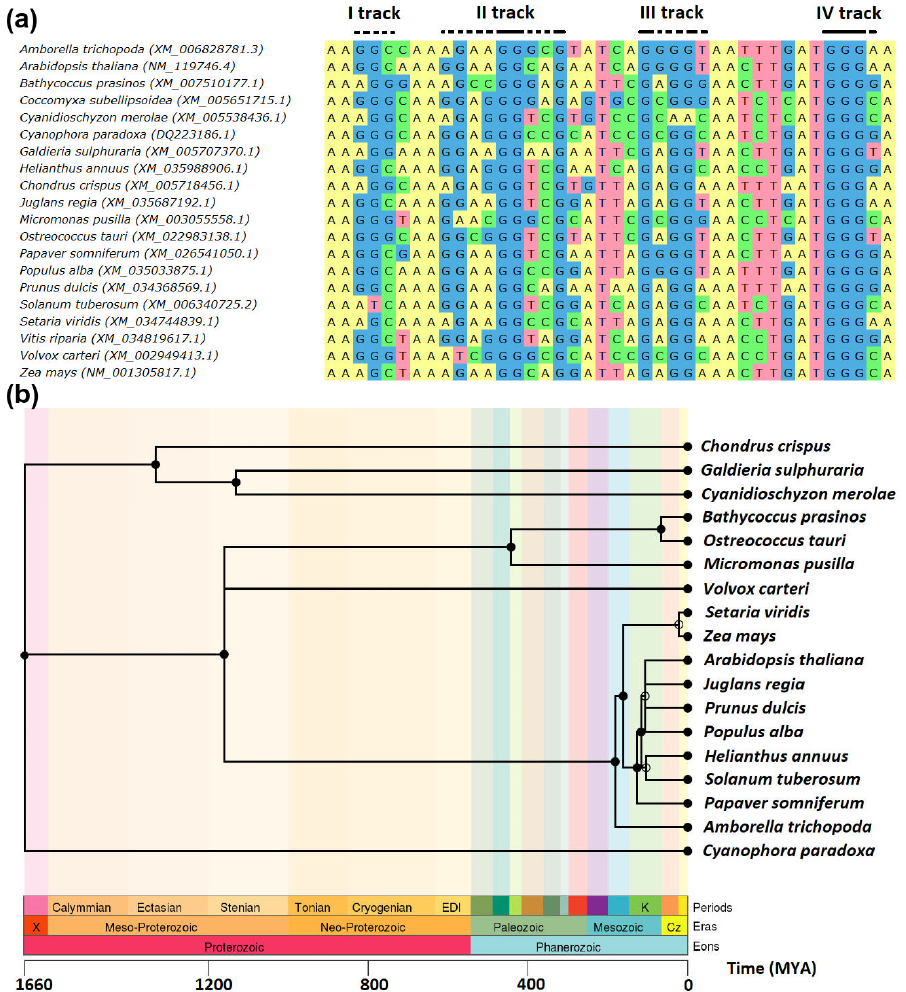
Figure 1. Conserved G4 locus in the RPB1 gene. ( a ) Multiple sequence alignment of conserved G4-forming loci inside the gene coding for the large subunit of RNA polymerase II (RPB1). The alignment was constructed using the MUSCLE algorithm [34] via UGENE workflow [35]. Mainly the second (II) and fourth (IV) guanine tracks show strong conservation of guanine residues. ( b ) Taxonomic tree with the time of branching estimations (MYA) constructed using the TimeTree tool [36]. Coccomyxa subellipsoidea is omitted here because of its unclear phylogeny.